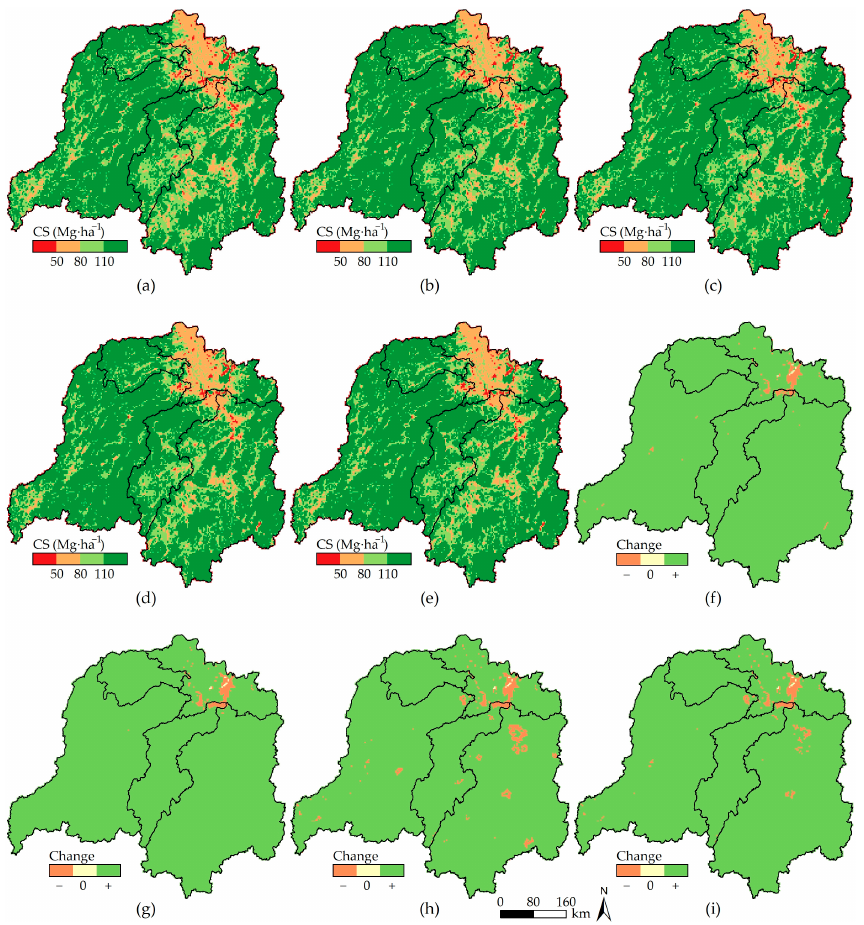
Figure 5. CS and its changes in DLB from 2020 to 2030. ( a – e ) Spatial distribution of CS in ( f – i ) changes in CS